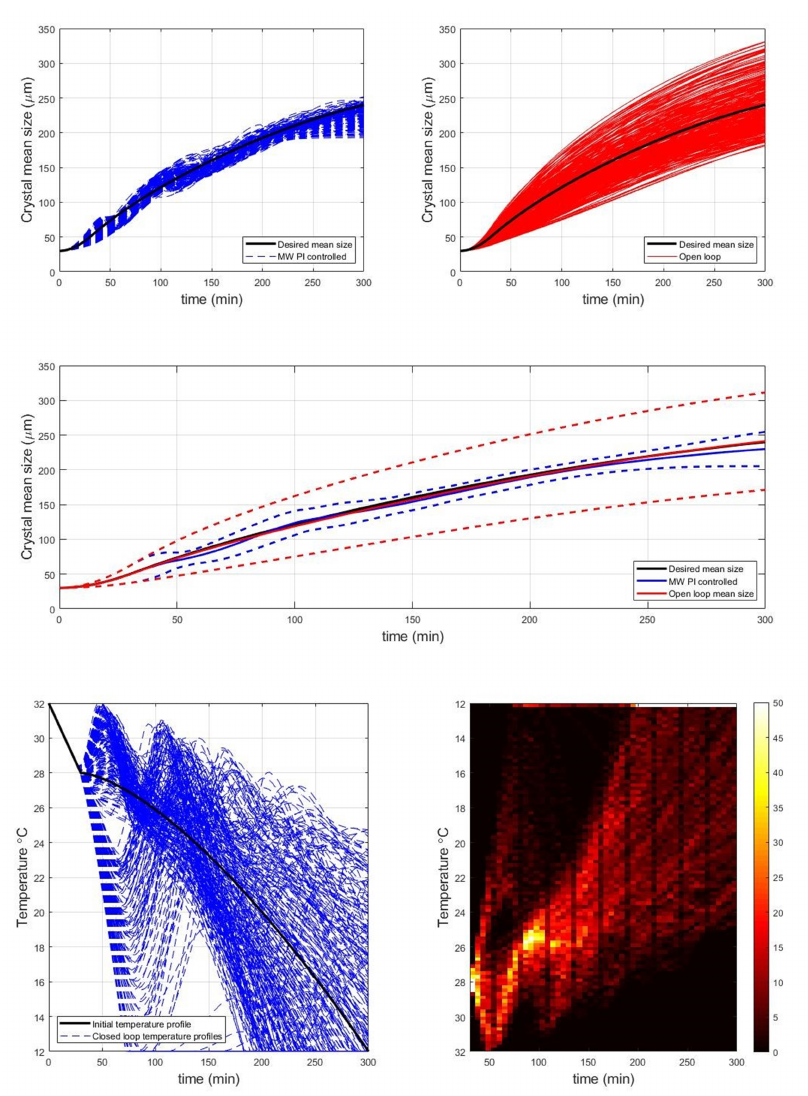
Figure 5. Controlled mean crystal size ( upper left corner ), open-loop mean crystal size ( upper right corner ), 95% confidence interval of controlled and open-loop cases ( middle ) and corresponding controlled temperature profiles ( bottom-left ) and heat map of the temperature profiles ( bottom-right ) over the course of the simulations obtained for the application of the Moving Window methodology to the RBF soft sensor with Monte Carlo sampling disturbances (300 Latin Hypercube Sampling (LHS) samples simulated